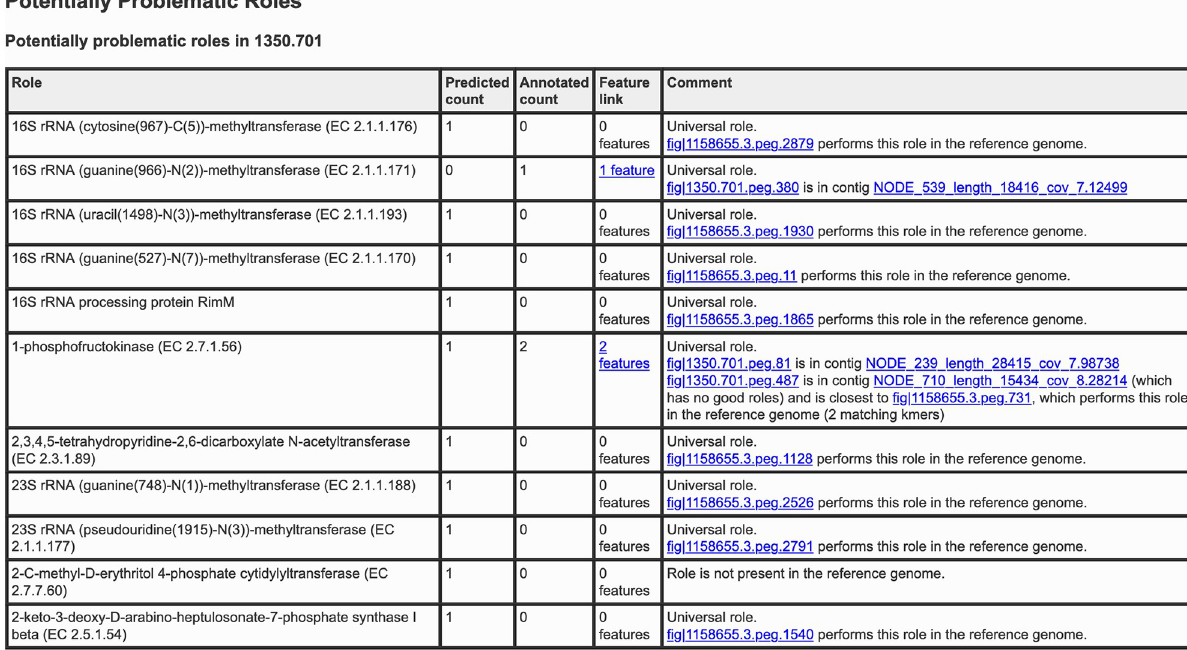
Fig 4. Sample problematatic role report. The problematic role report is generated per genome bin and reports on all genes whose observed multiplicity disagrees with PATRIC predictors. There are a number of reasons that a gene may appear in this report, including missing roles due to deletions, incompleteness, or frameshift mutations (observed multiplicity less than predicted); duplicate roles due to contamination or other binning issues (multiplicity more than predicted). The problematic roles report provides other information, such as whether a gene is known to be single-copy in general, and which genes have analogs in the reference genome. This information can help users discriminate between interesting variations from the reference genome and errors introduced in the binning, assembly, or sequencing stages.